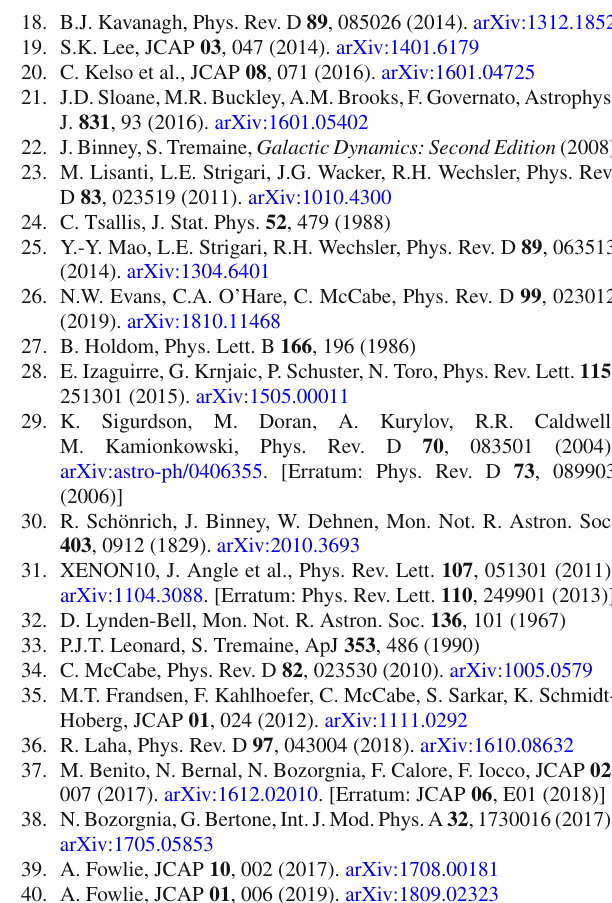
this appears around a DM mass of 200 MeV, however for F DM ∝ q − 2 this crosses the boundary of the figures, as depicted in the left panels of the aforementioned